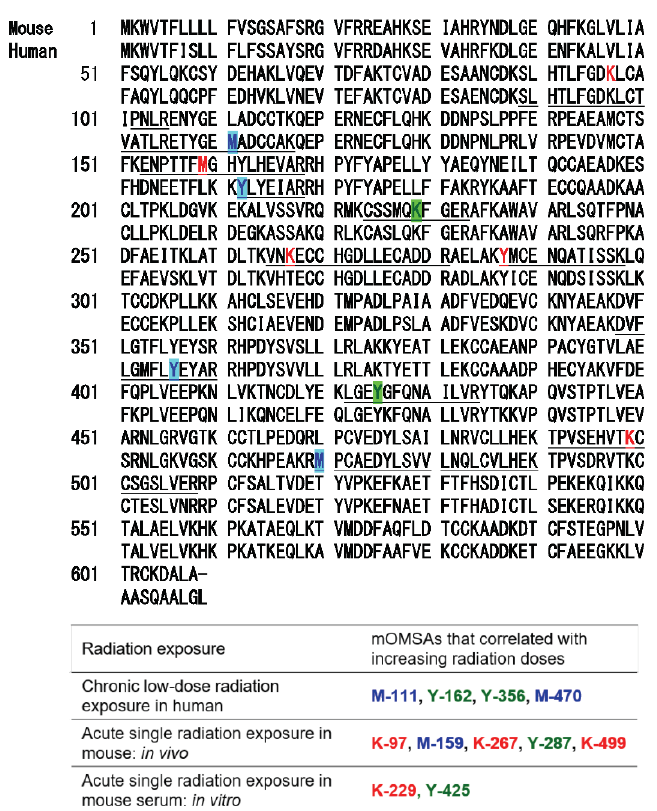
Figure 5. Comparison of oxidative modification sequences of human and mouse serum albumin. Based on the results of our previous report [1], the oxidative modification sites of the serum albumin obtained in this study were compared. Among the identified amino acid sequences of mouse albumin, lysine, methionine and tyrosine underwent dose-dependent oxidative modification. Oxidation-modified amino acids in chronic low-dose radiation exposure in humans, acute single radiation exposure in mice (in vivo), and acute single radiation exposure in mouse serum (in vitro) (Table).